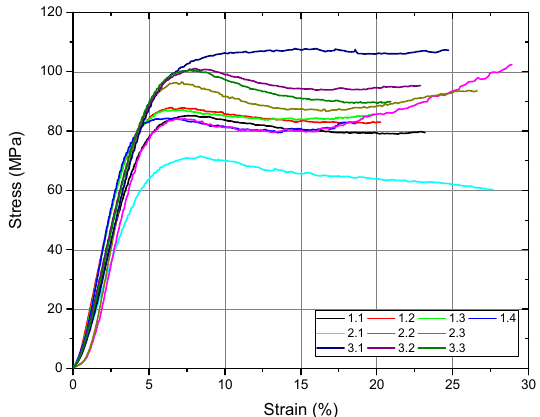
Figure 9. Diagram with the results for compression testing for all experimental samples (sample 1—